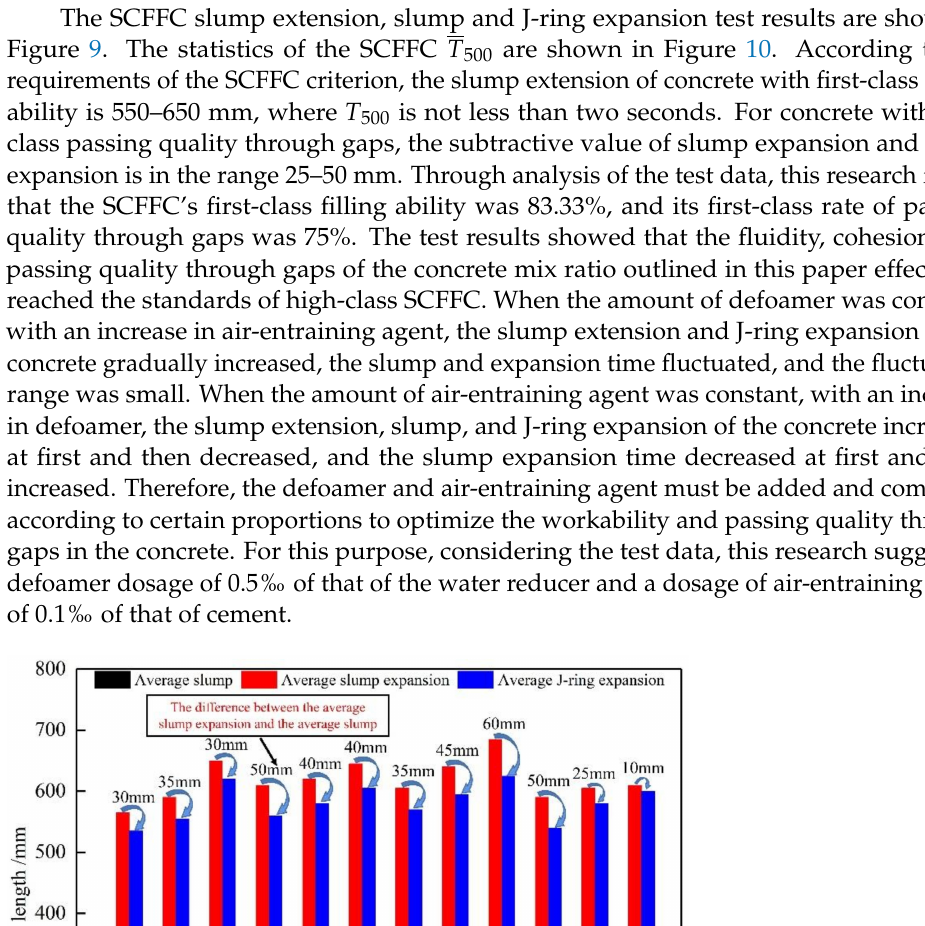
Figure 8. SCFFC J-ring expansion test.